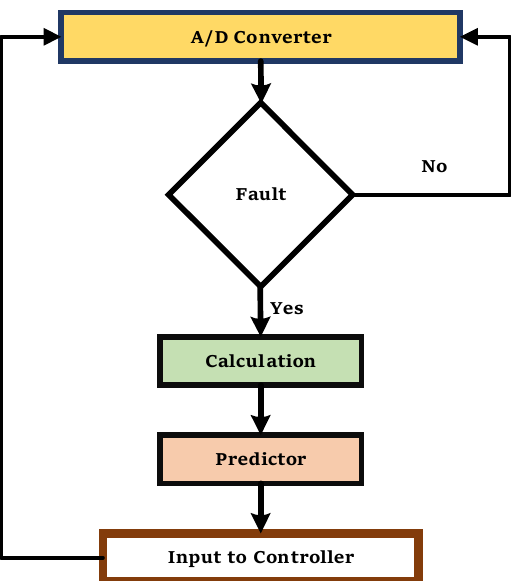
Figure 8. Predictor model.